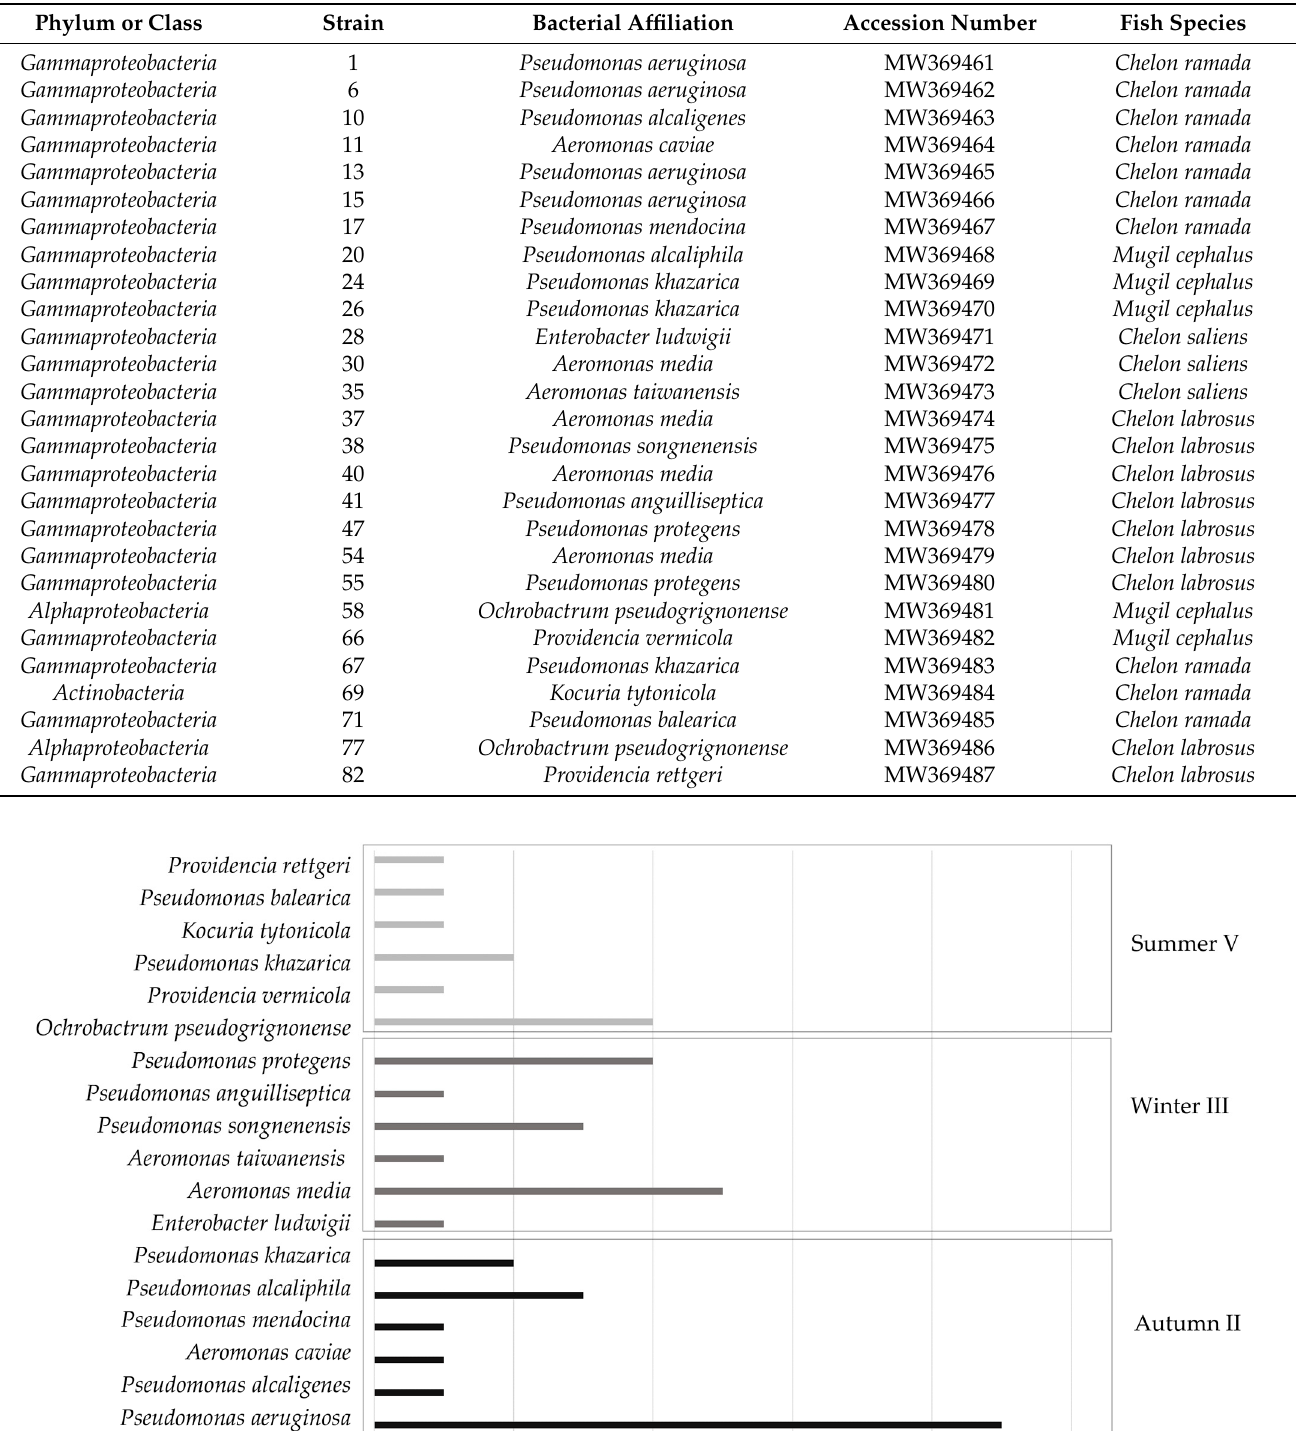
Table 2. Different bacterial affiliation of intestinal isolates from grey mullets and accession number by GenBank.